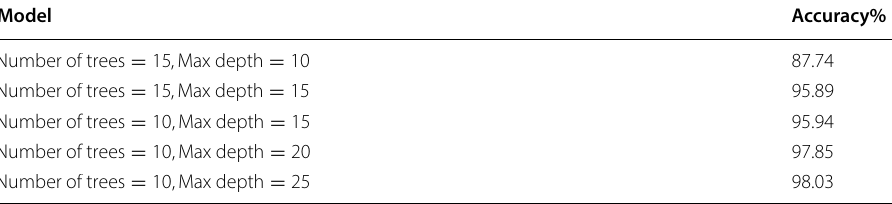
Table 10 RF results for multi classification